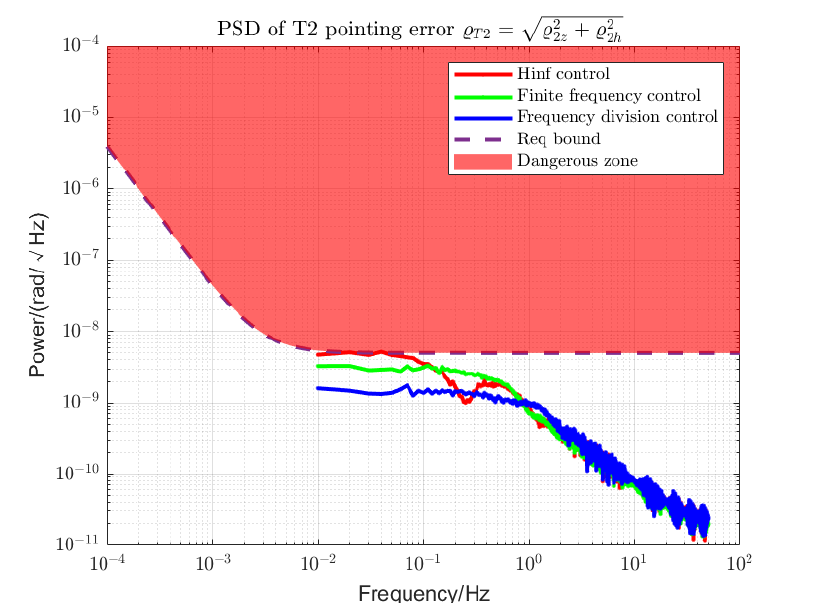
Figure 13. PSD of T2 LOS pointing error. The red area above the dotted line is a hazardous area that exceeds the specified limits. The control performances of the loop-shaping control, finite frequency control, and frequency division control are